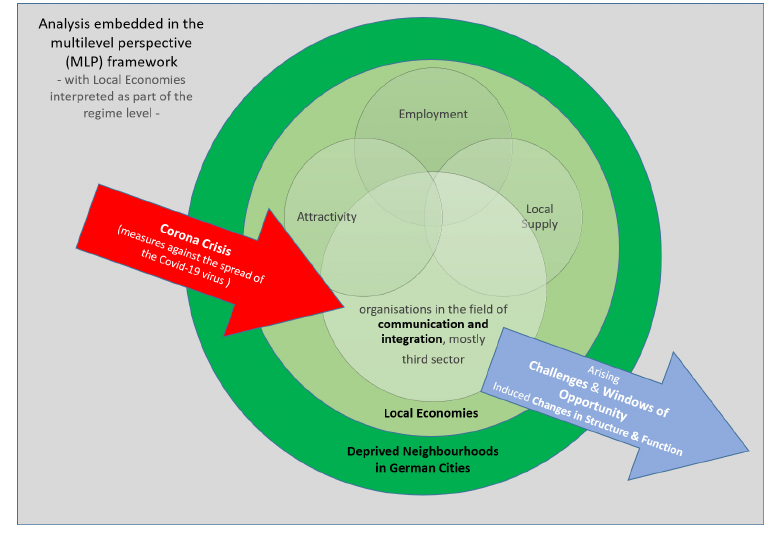
Figure 1: Visualization of the research